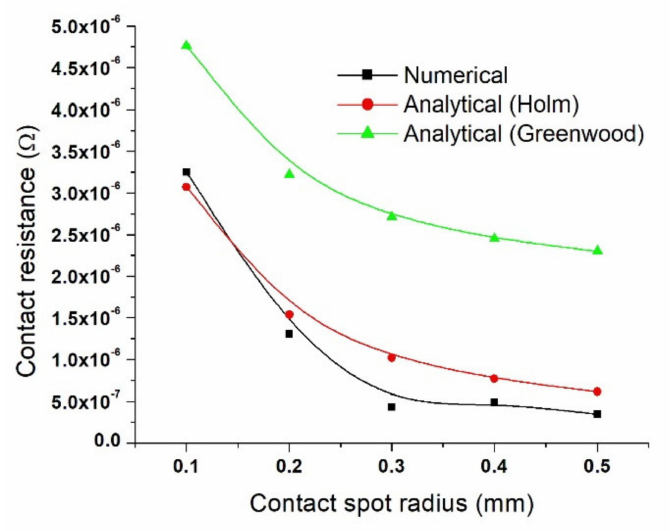
Figure 11. Contact resistance showing values for Holm and Greenwood (analytical) and numerical analysis calculated for ( ρ Cu = ρ Cs = 1.72 · 10 − 8 Ω · m).